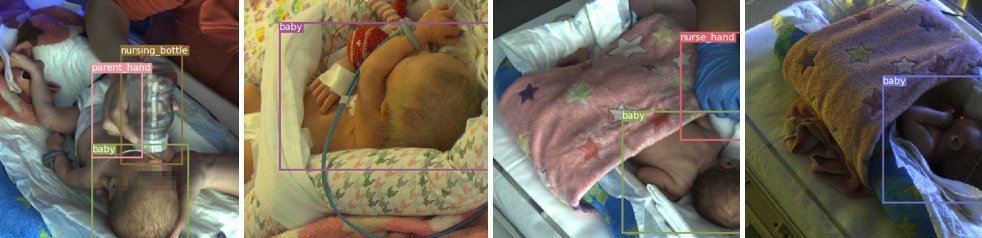
Figure 8. Static analysis: object detection examples, which are used in the top-level classifier to separate and identify excessive motion, caring, empty incubator, etc. categories during operation. The ROI of neonates is passed to the pulse